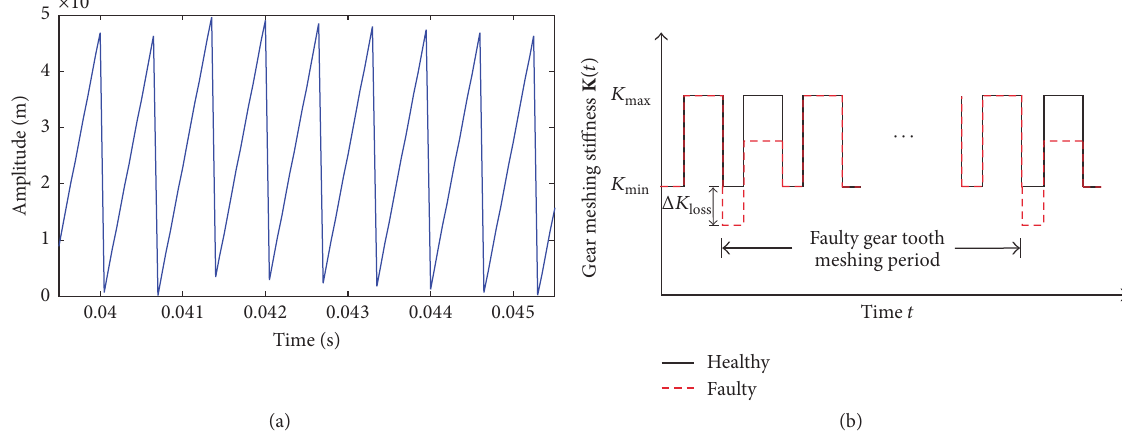
Figure 8: (a) Error function and (b) gear mesh stiffness under the healthy and faulty